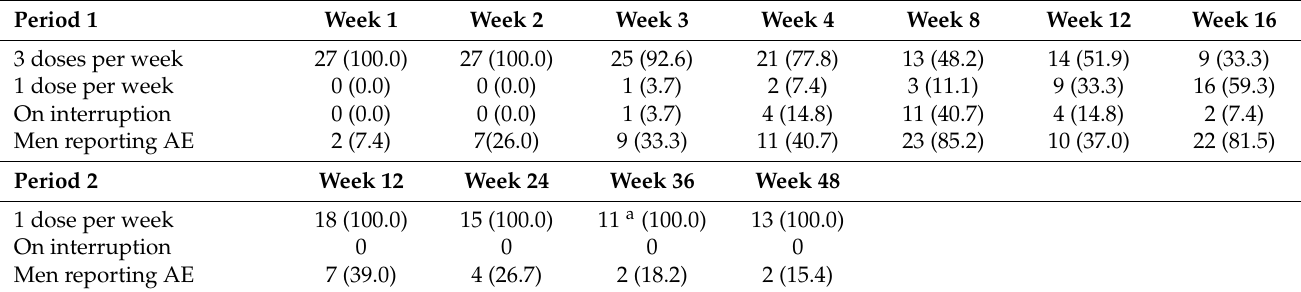
Figure 1. Flowchart of participant progress through each period of the trial. a One participant had an active herpes genitalis episode and had to be excluded from the study. b Other reasons were moving interstate or overseas ( n = 2) and work commitments ( n = 1). Table 2. Adherence to imiquimod by week of follow-up during period 1 and period